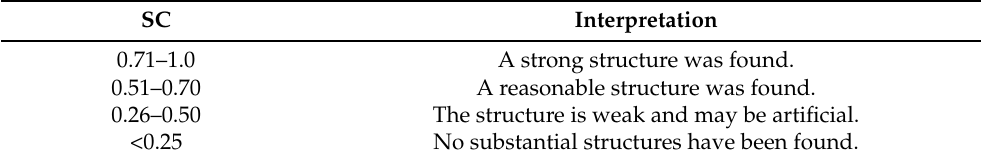
Table 1. Structures corresponding to particular Silhouette coefficient ranges. SC